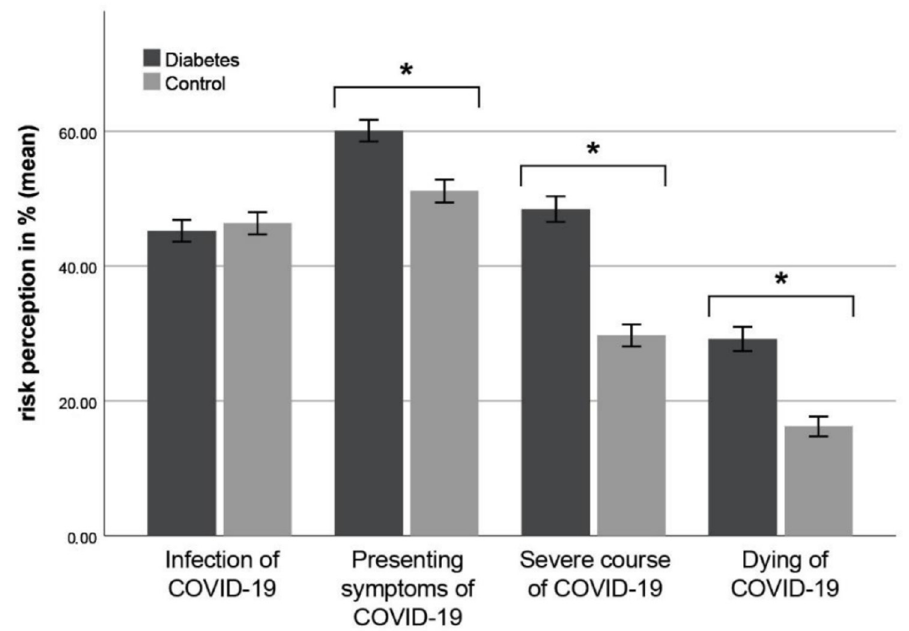
Figure 1. Risk perception in patients with diabetes compared to controls. * p < 0.001, error bars: 95%.